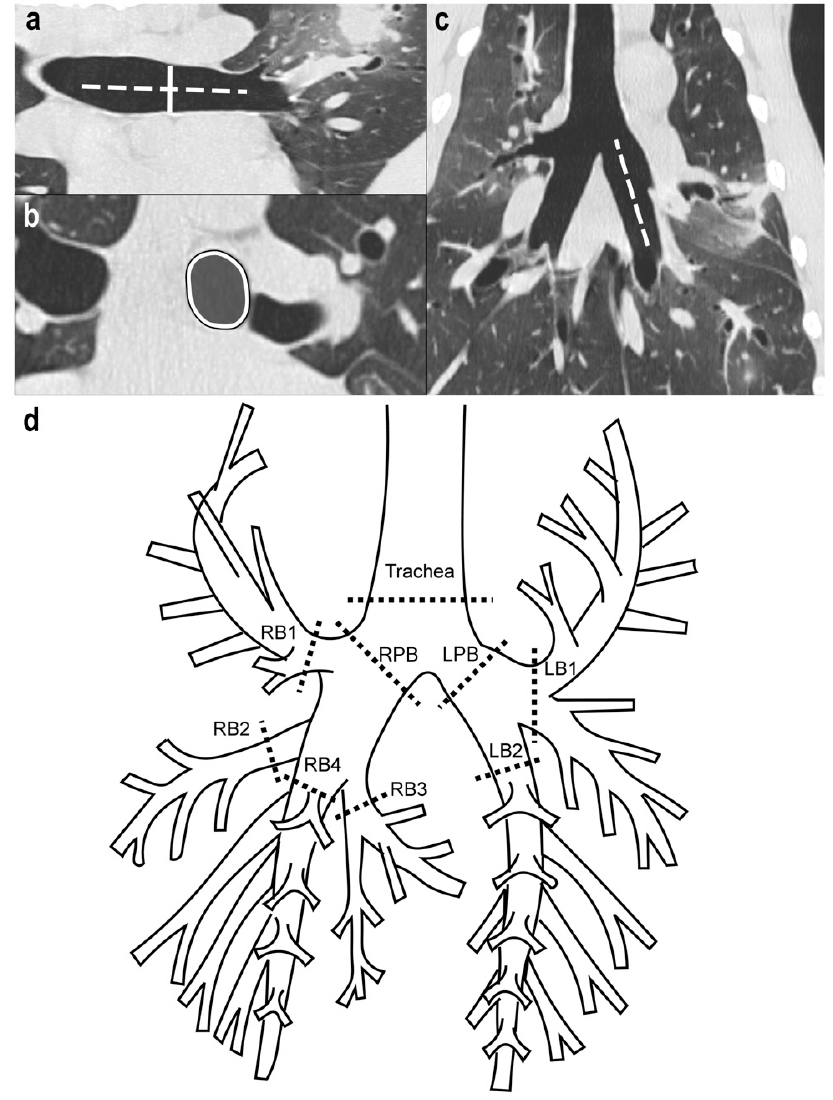
Figure 1. Assessment of diameter- and cross-sectional area (CSA)-derived airway caliber on computed tomography (CT) images. ( a – c ) Three-dimensional curved multiplanar reconstruction allowed to us to determine the long axis of each airway based on sagittal ( a ) and dorsal ( c ) planes. As illustrated for LB2, a solid line ( a ) was then drawn perpendicular (dotted line) to the long axis of the airway representing the internal dorsoventral diameter (( a ), solid line), and the airway is outlined (( b ), solid line with gray center), thus generating the CSA of the airway. As shown in ( d ), dorsoventral diameters and CSA were obtained for each airway at each location (dotted lines) on the schematic representation of the tracheobronchial tree of the dog on both CT scans and tracheobronchoscopy. All of the measurements were performed by a single observer (A.L.) using non-contrast MPR images with a default lung window (window level = − 550 Hounsfield units (HU), window width = 1600 HU), and image magnification of 1000% after importation of CT DICOM images from the UMVHC PACS to a PACS belonging to the Centre Hospitalier Universitaire Vétérinaire, and these were viewed on a dedicated workstation (Impax 6.0, Agfa, Toronto, ON, Canada). RPB, right principal bronchus; LPB, left principal bronchus; RB1, right cranial lobar bronchus; RB2, right middle lobar bronchus; RB3, right accessory lobar bronchus; RB4, right caudal lobar bronchus; LB1, left cranial lobar bronchus; LB2, left caudal lobar bronchus.